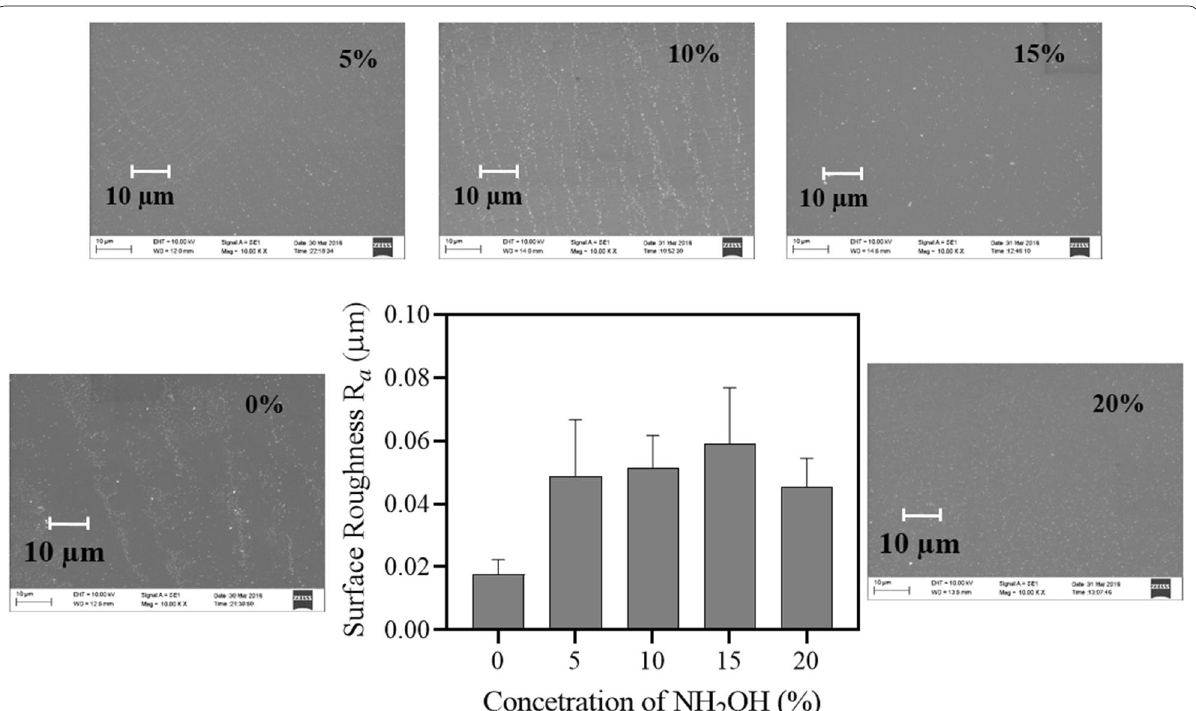
Fig. 44 Etched surface roughness (Ra) and corresponding surface morphologies of Si{111} in pure and different concentrations of NH 2 OH added in 20 wt% KOH at 75 1 °C [51] ±